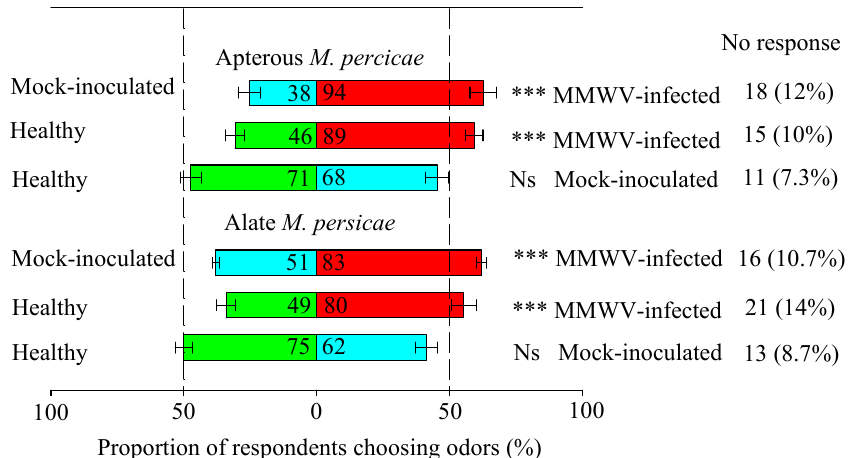
Figure 2. The response of Myzus persicae to di ff erent odor stimuli. For each pair of stimuli, a total 150 M. persicae were tested by the Y-shaped olfactometer. Data were presented as the mean ± SE. Bars denoted by asterisk indicate a significant preference for the treatment (* p < 0.05, ** p < 0.01, *** p < 0.001). Ns: No significant di ff erence ( p > 0.05). Healthy plants are shown in green; MMWV-infected plants are shown in red; Mock-inoculated plants are shown in blue. Numbers of individuals that responded or did not respond are